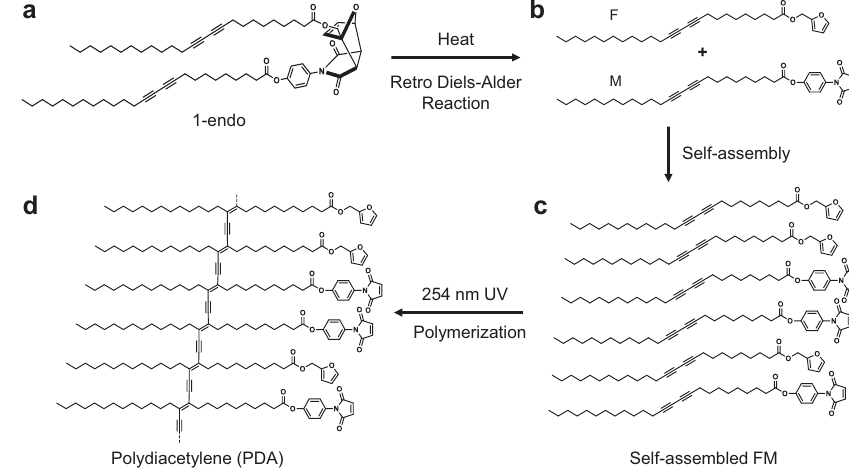
Fig. 2 Schematic diagram of retro Diels – Alder (rDA) reaction, self-assembly, polymerization of 1-endo. a Molecular structure of an endo form of diacetylene-containing Diels – Alder adduct 1-endo. b Structures of diacetylene-containing furan F and maleimide M, generated by retro Diels – Alder reaction of 1-endo. c A self-assembled structure of F and M. d Polydiacetylene (PDA) produced by 254 nm UV-irradiation of self-assembled diacetylenes F and M.